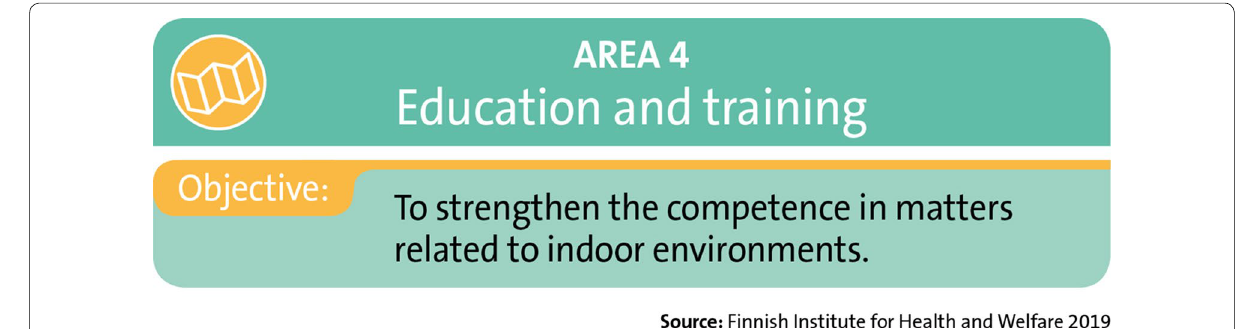
Fig. 9 The objective of area